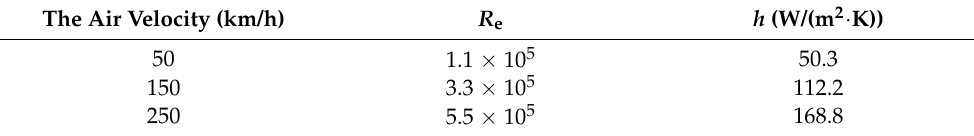
Table 5. Air heat transfer coefficient at different flow rates.